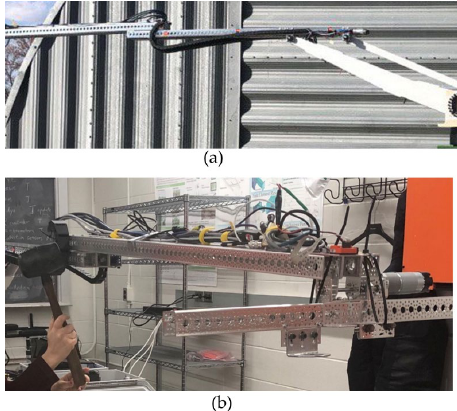
Figure 20. ( a ) the 5-DOF manipulator at fully-extended configuration, ( b ) hammer test to the fully- extended manipulator for experimental modal analysis.